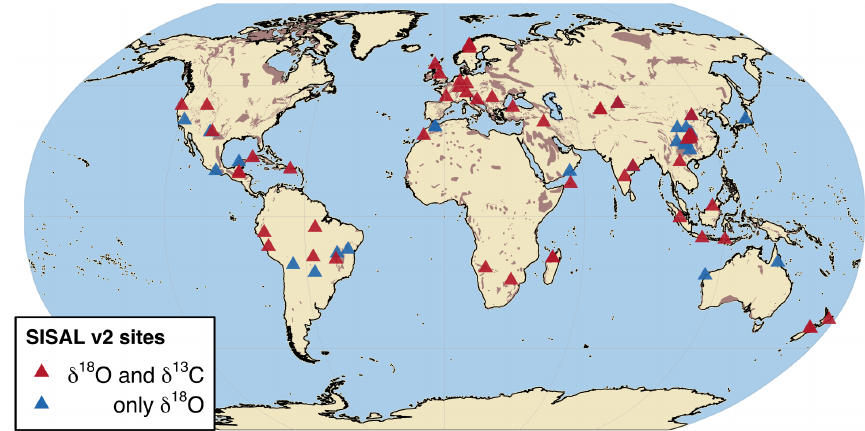
Figure 2. Site locations of the SISALv2 database on a global karst map (brown shading by Williams and Ford, 2006). We only consider entities that cover a minimum 600-year period within the last millennium and that include at least 2 dates and 36 isotopic measurements in this period. Shown are all sites within the last millennium meeting these selection criteria that have both oxygen and carbon isotope measurements (red) and only oxygen isotope measurements